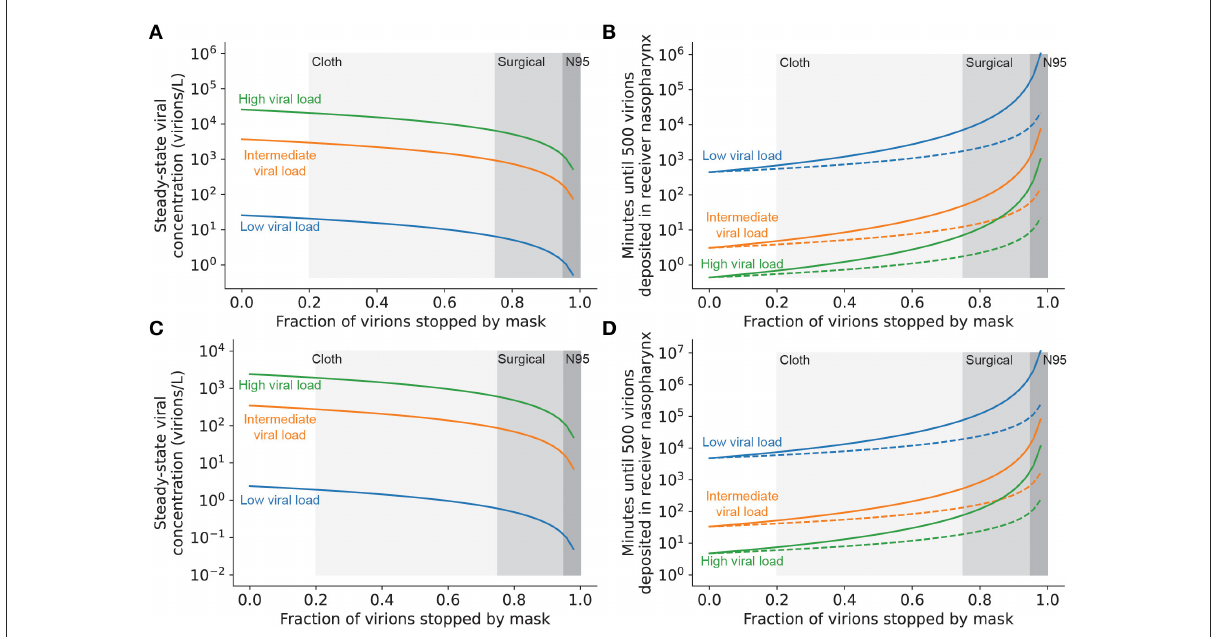
FIGURE6 Masking both infected and uninfected individuals reduces the rate of viral transmission. (A) Steady-state airborne viral concentration in an unventilated classroom with a single infected individual wearing a mask with the filtration efficiency given on the x-axis. (B) Time until infection of uninfected individuals present in an unventilated classroom with a single infected individual wearing a mask with the filtration efficiency given on the x-axis. Uninfected individuals either are not wearing masks (one-way masking; dashed lines) or are wearing a mask with the same filtration efficiency as the infected individual (two-way masking; solid lines). (C) Steady-state airborne viral concentration in a well-ventilated classroom (6 complete air exchanges per hour) with a single infected individual wearing a mask with the filtration efficiency given on the x-axis. (D) Time until infection of uninfected individuals present in a well-ventilated classroom with a single infected individual wearing a mask with the filtration efficiency given on the x-axis. Uninfected individuals either are not wearing masks (one-way masking; dashed lines) or are wearing a mask with the same filtration efficiency as the infected individual (two-way masking; solid lines). In all panels, shaded regions denote typical filtration efficiencies for cloth, surgical, and N95 masks (Supplementary material S6) and curve colors denote viral load of the